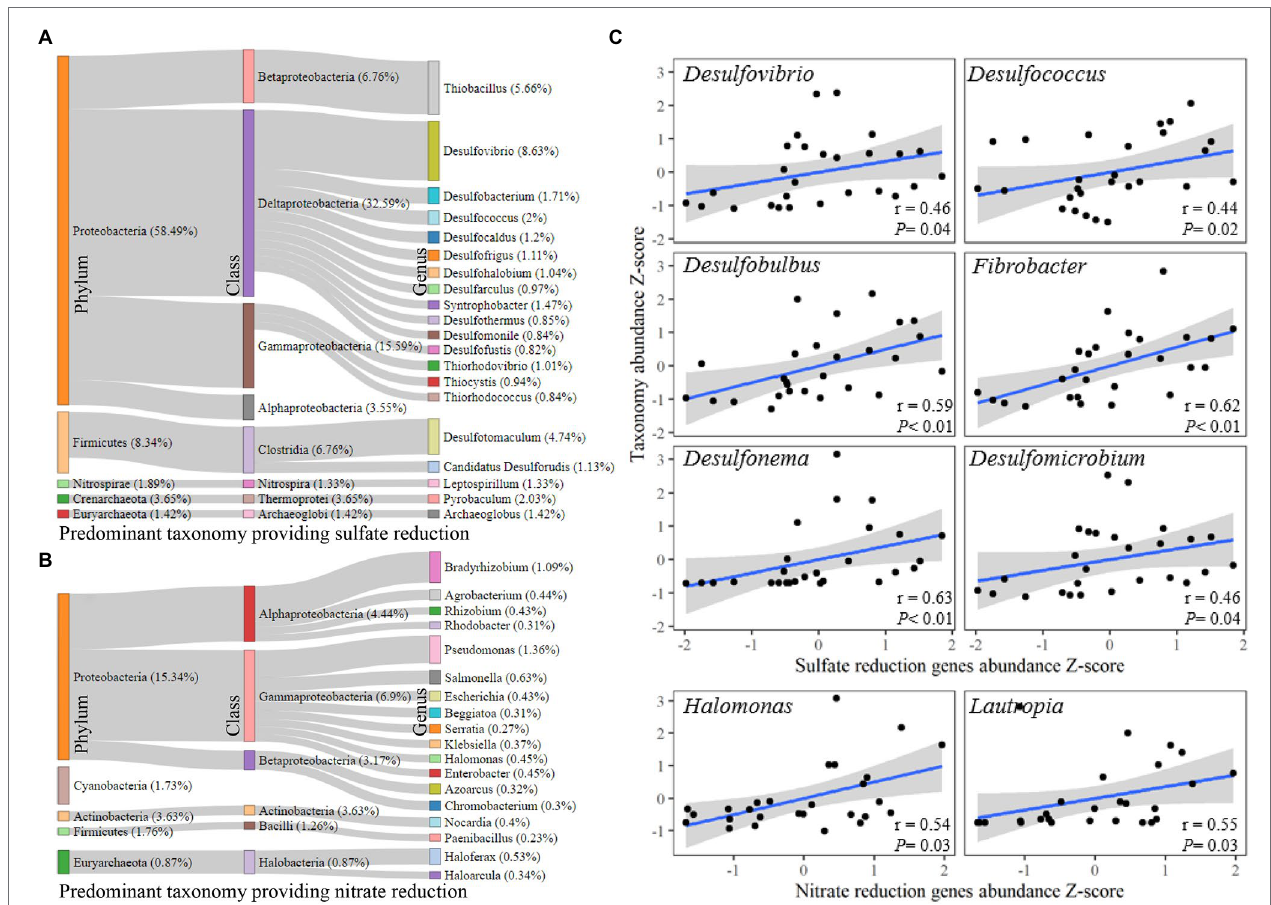
FIGURE 3 | Taxonomic response to nitrate and sulfate reduction. (A) Taxonomic relationships with sulfate reduction. (B) Taxonomic relationships with nitrate reduction based on functional gene host (source). (C) Bacterial genera correlated with sulfate and nitrate reduction according to 16S amplicon operational taxonomic units (OTUs). The correlation analysis was conducted using Spearman’s rank